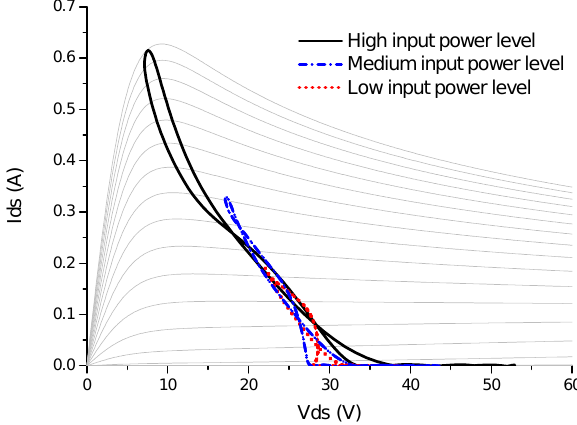
Figure 14. Load lines of class-C-F PA with respect to different input power